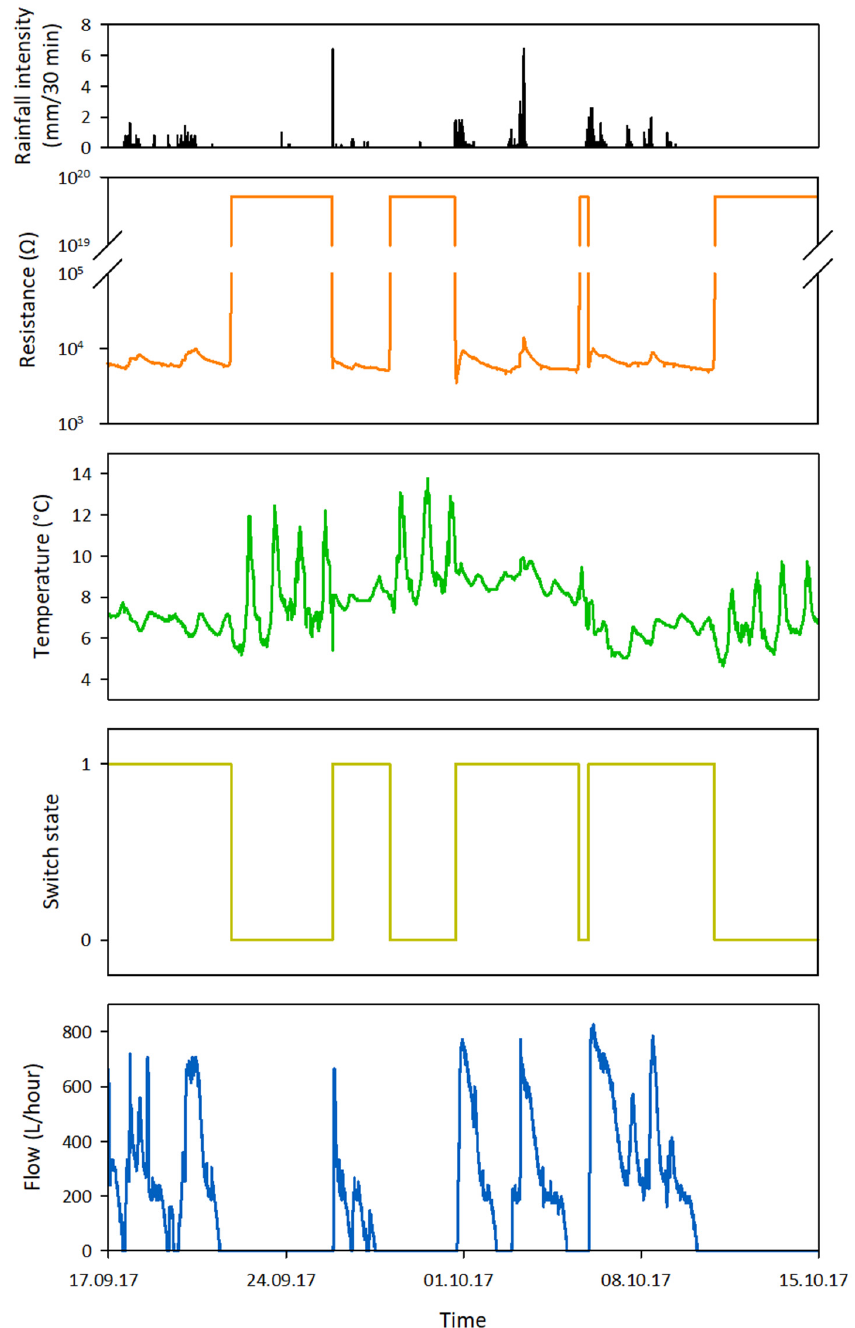
Figure 3. An example of four weeks of raw sensor data for the multi-sensor monitoring system together with the 30-minute rainfall intensity during this period.